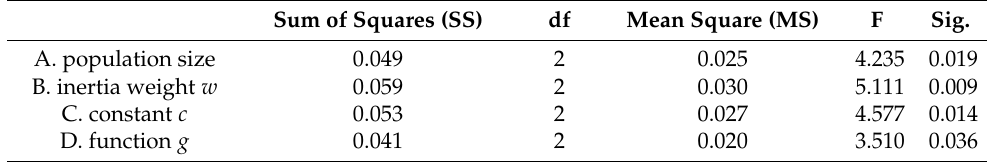
Table 4. ANOVA results for the obtained results of